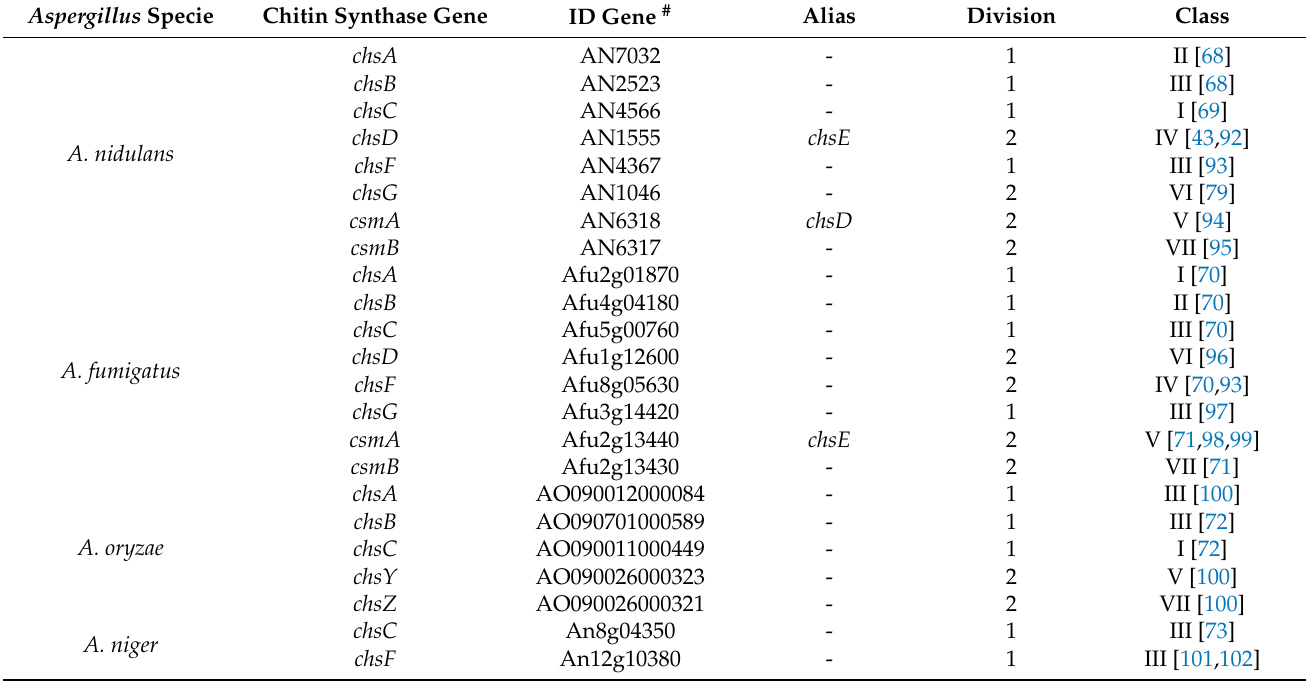
Table 1. Chitin Synthase genes on Aspergillus species classified into divisions and